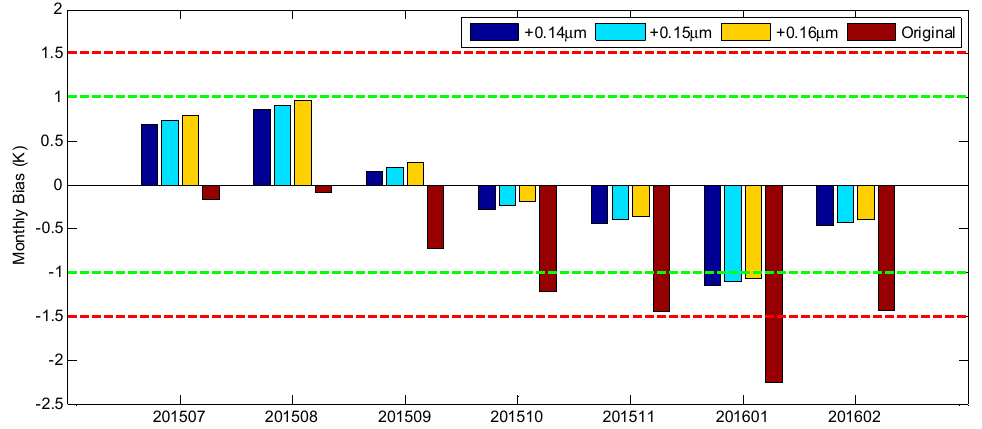
Figure 7. Monthly biases of the FY-2G IR2 band with different shifted values of SRF ITS: 5 µ m against those of its original one.